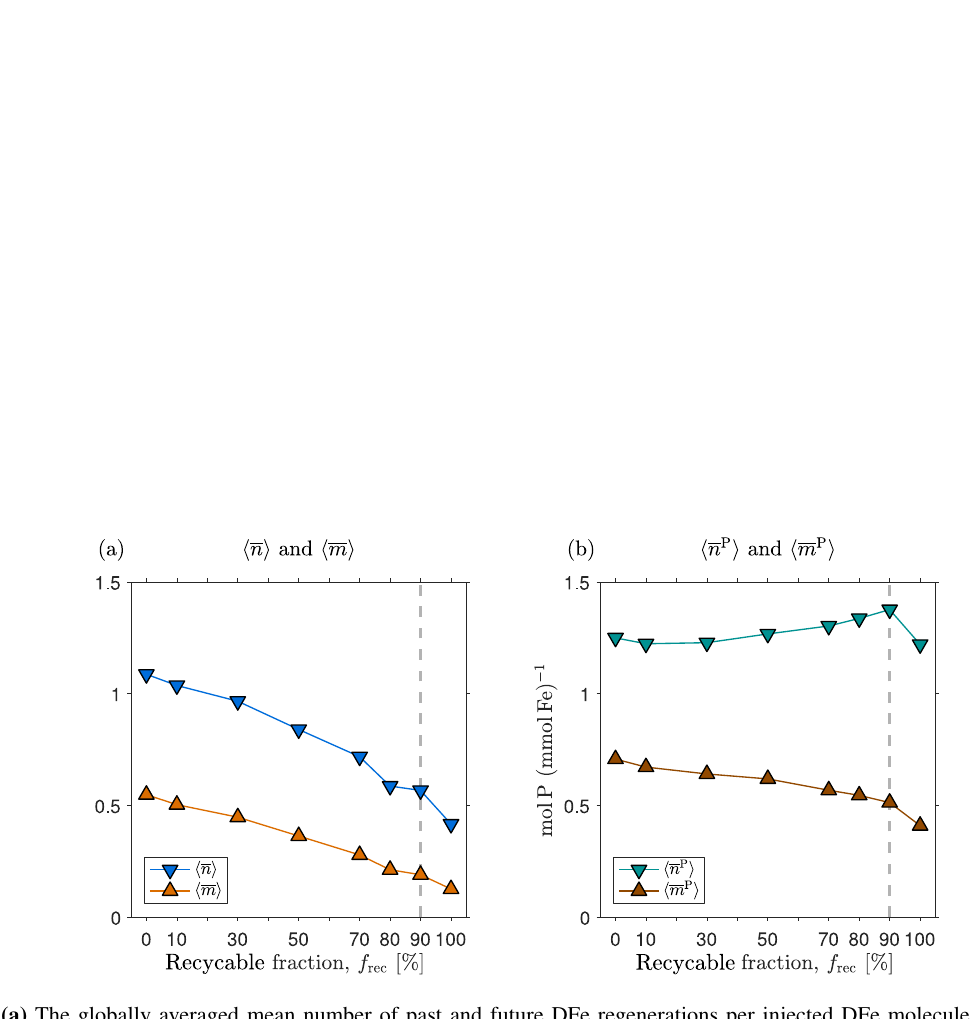
Figure D2. (a) The globally averaged mean number of past and future DFe regenerations per injected DFe molecule, (cid:104) n (cid:105) and (cid:104) m (cid:105) , as a function of the recyclable fraction f rec . The corresponding states were obtained by changing the value of f rec of the typical state and re- optimizing all other source and scavenging parameters. The typical state has f rec = 90% and is indicated by the vertical dashed line. Panel (b) is the same as panel (a) but for the past and future number of phosphorus molecules exported per injected DFe molecule, (cid:104) n P (cid:105) and (cid:104) m P (cid:105)